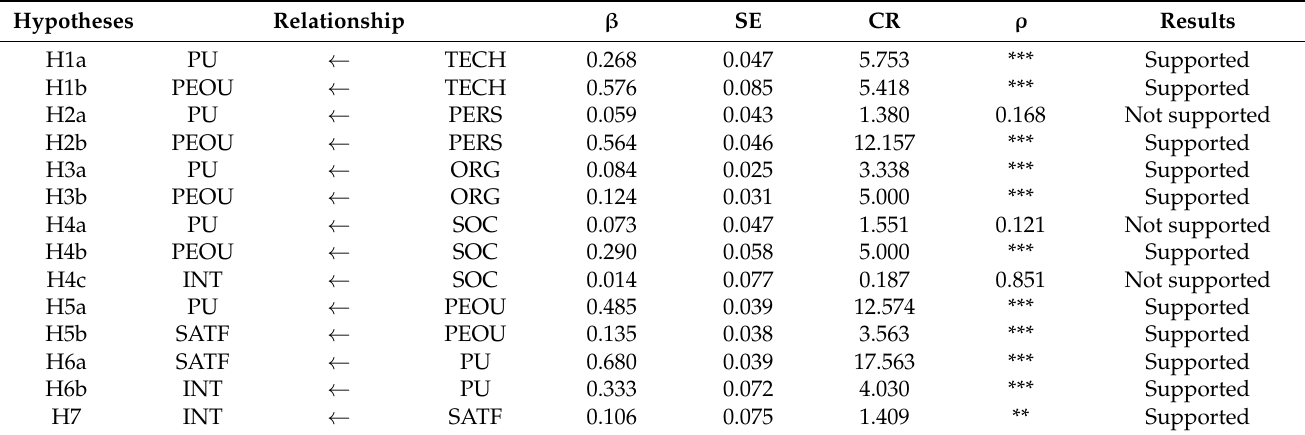
Table 7. Verification results of the structural equation model’s influencing relationship on the theoretical